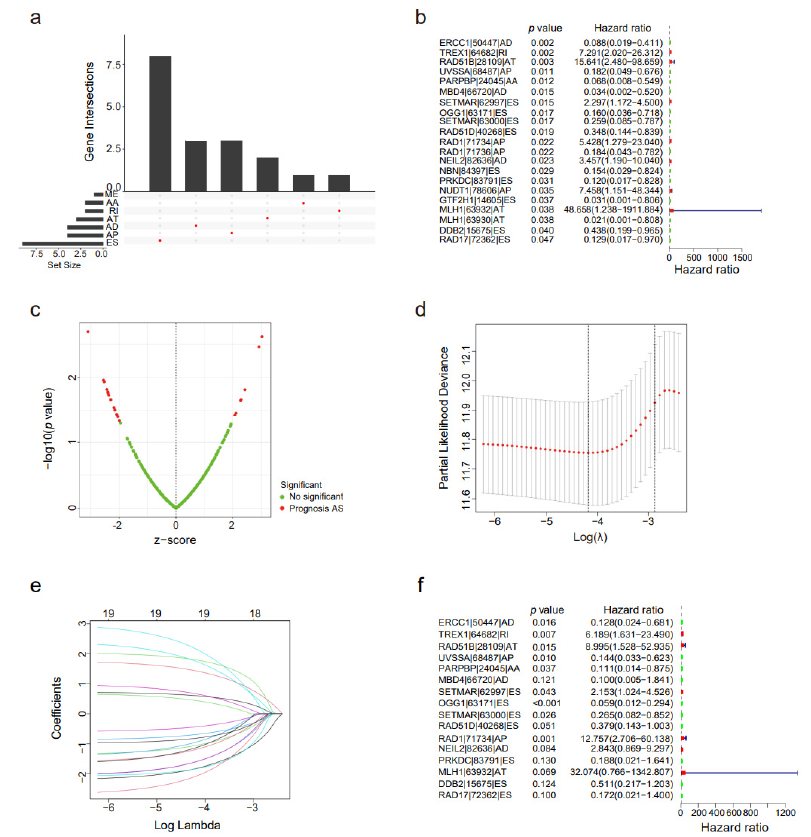
Figure 2. Results and constructions of the independent prognostic model. ( a ) UpSet plots of seven kinds of prognosis-related optional splicing events and their parent genes. The lower part of every plot describes the permutations of the optional splicing events; for every situation, the optional splicing event is comprised if its counterpart is full of a red dot. The higher part of the plot symbolizes the amounts of genes for every situation. Average PSI value ≤ 0.05. ( b ) The forest plot of prognosis- related AS events in the STAD cohort. ( c ) The volcano plot of prognosis-related AS events in the STAD cohort. ( d ) Lasso plot determining the amount of whole survival-related splicing events in